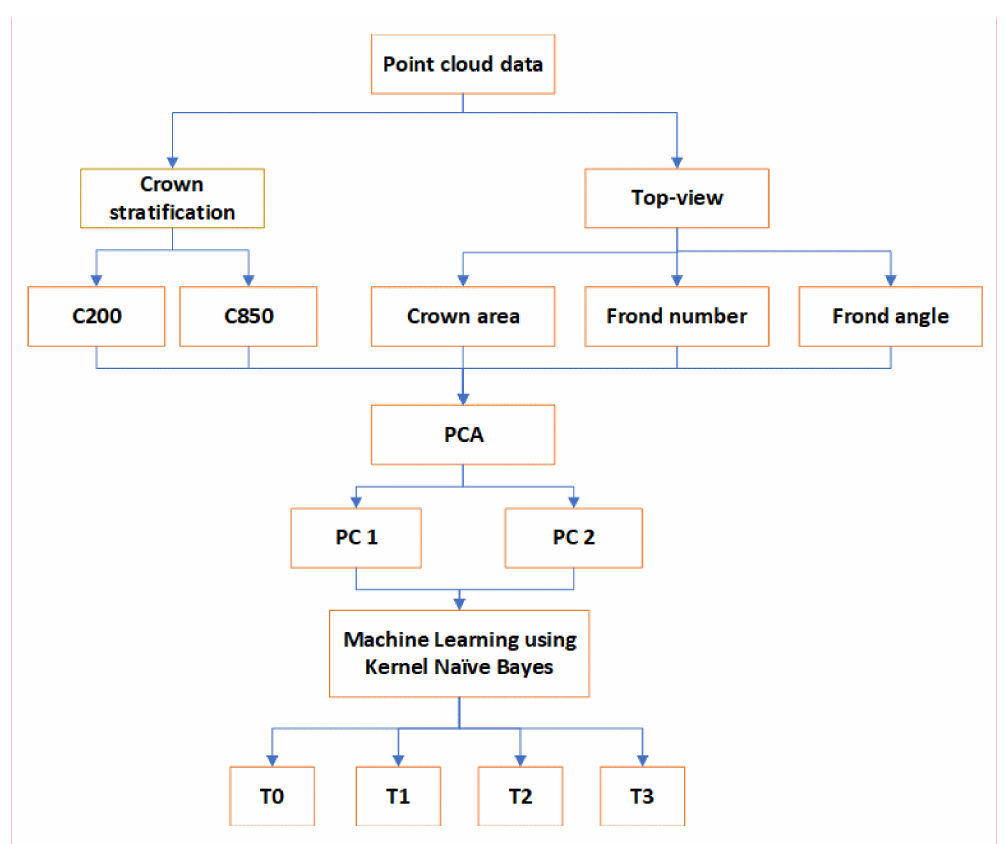
Figure7. FlowoftheKNBmethodfordetectingandclassifyingtheBSRintofourdi ff